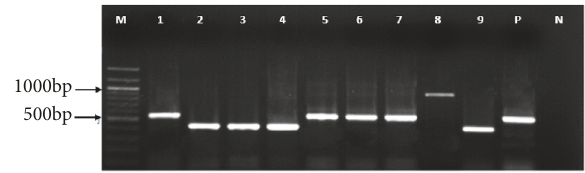
Figure 4: A 1% agarose gel showing the representative results obtained from amplification of the central variable region of the p72 gene of African swine fever virus using the CVR primers. Lane M: 𝜆 DNA-Hind III and 𝜙 x174 DNA-Hae III mix (Finnzymes) 100bp molecular weight DNA marker; Lane P is a positive control. Lanes 1, 2, 3, 5, 6, and 9 are selectedpositive samples with varying band